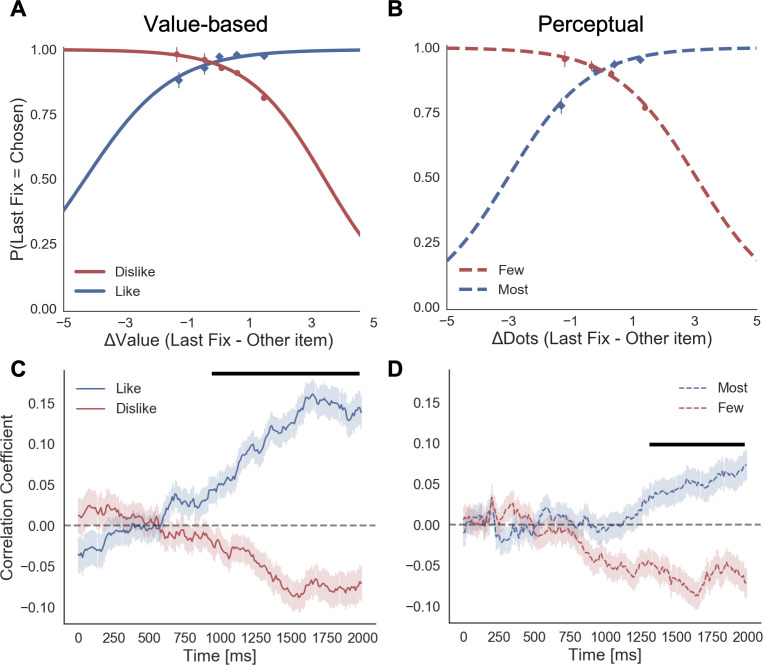
Fixation effects on the chosen item.Last fixation effects: (A) in the Value Experiment, a logistic regression was calculated for the probability the last fixation is on the chosen items (P(LastFix = Chosen)) depending on the difference in value of the item last fixated upon and the alternative item. As reported in previous studies, in like frame, we find it is more probable that the item last fixated upon will be chosen when the value of that item is relatively higher. In line with the hypothesis that goal-relevant evidence, and not value, is being integrated to make the decision, during the dislike frame the effect shows the opposite pattern: P(LastFix = Chosen) is higher when the value of the item last fixated on is lower, that is, the item fixated on is more relevant given the frame. (B) A similar analysis in the Perceptual Experiment mirrors the results in the Value Experiment with a flip in the effect between most and fewest frames. Lines represent the model predictions and dots are the data binned across all participants. ΔValue and ΔDots measures are z-scored at the participant level. Gaze preference in time: (C) Pearson correlation between gaze position and difference in value (ΔValue) was calculated for each time point during the first 2 s of the trials. In the Value Experiment, after an initial phase of random exploration, fixations are positively correlated with the high value item in like frame, while this effect is the opposite for dislike frame, that is, fixations are directed to the low value item. (D) In the Perceptual Experiment, a similar pattern of goal-relevant fixations emerges. Lines in both figures correspond to the time point correlation considering all trials and participants. Shaded area corresponds to the standard error. Black line indicates time points with statistically significant difference between frames, resulting from a permutation test (p-value<0.01 for at least 6 time bins, 60 ms). Correction for multiple comparison was performed using FDR, α ≤ 0.01.